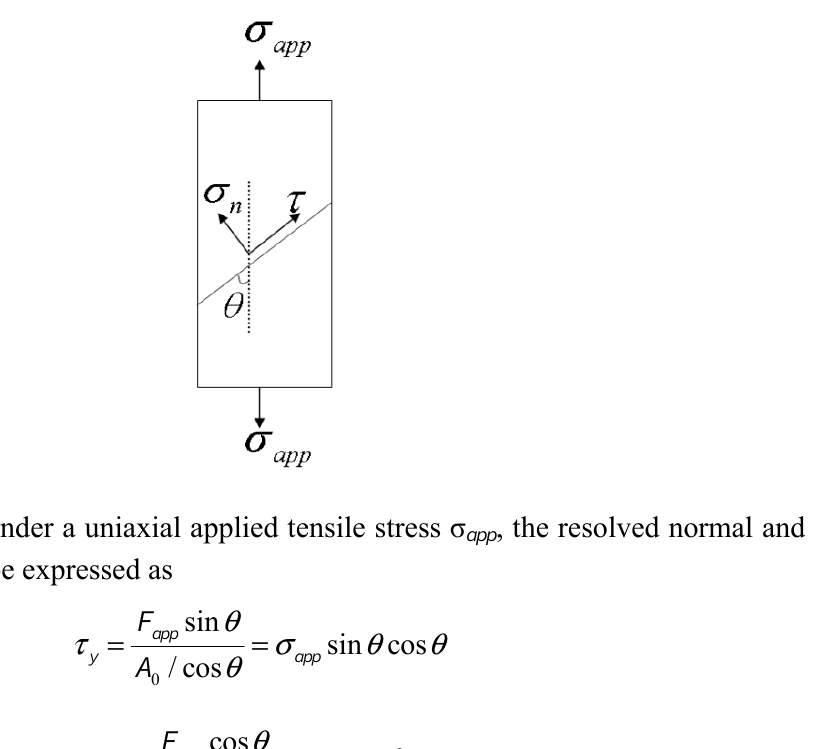
Figure 1. The two-dimensional illustration of the Coulomb-Mohr